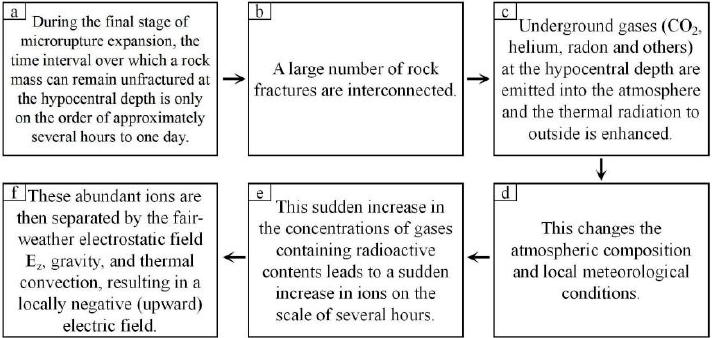
Figure 3. Logical flow diagram illustrating the hourly scale physical processes leading up to an earthquake. Subfigures a-f are the sequential physical logic diagrams in order. earthquake. Subfigures a-f are the sequential physical logic diagrams in